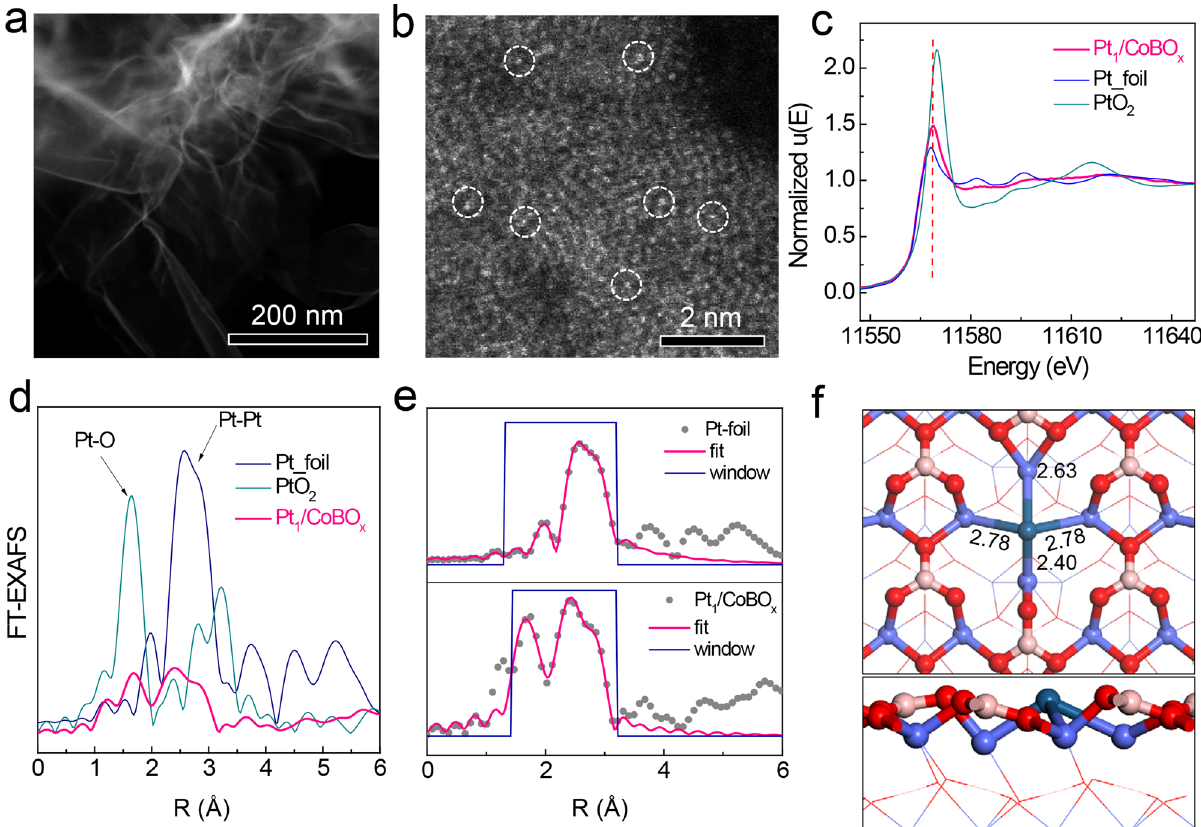
Fig. 2 Characterizations of the Pt 1 /CoBO x catalyst. a Dark fi eld TEM and b HAADF-STEM images of Pt 1 /CoBO x . c XANES and d EXAFS of Pt 1 /CoBO x , Pt foil, and PtO 2 powder. ( k 3 weighted data). e Curve fi ttings of EXAFS data. f Calculated model of Pt 1 /CoBO x . The cyan, blue, red, and pink balls represent the Pt, Co, O, and B atoms,